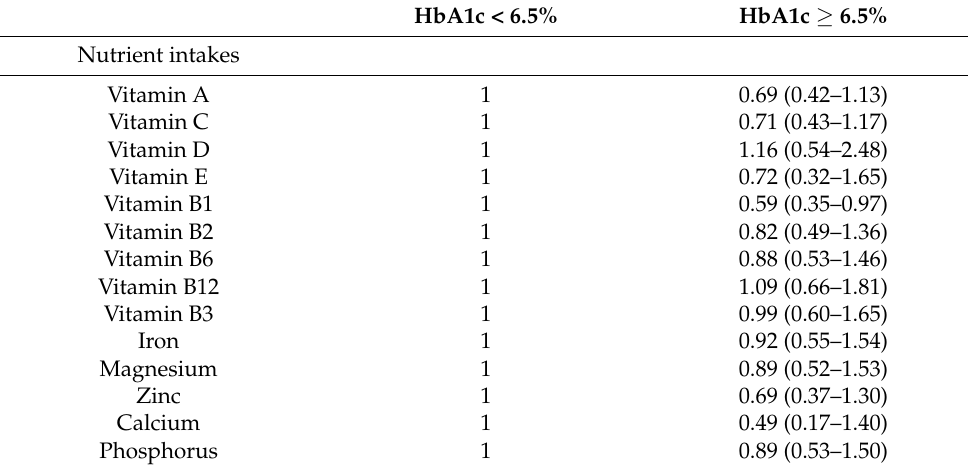
Table 3. The associations between adherence to the DRIs of selected micronutrients and the risk of having type 2 diabetes